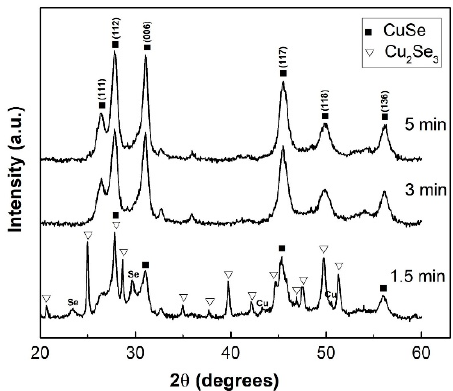
Figure 2. XRD patterns of Cu/Se mixtures milled in the planetary mill for 1.5, 3, and 5 min. Typical reflections are assigned to corresponding phases: CuSe, Cu 2 Se 3 , Se = selenium, Cu = copper.